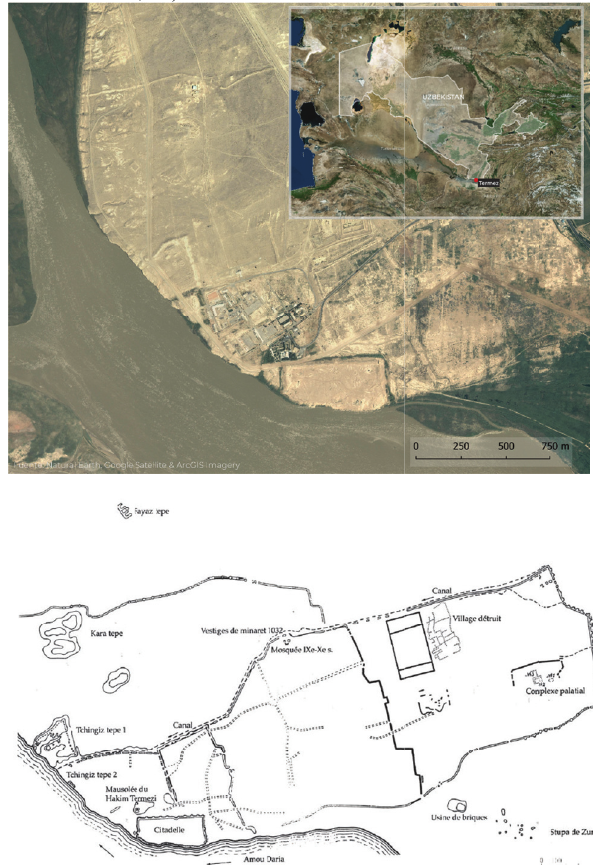
Figure 1. Loc close to the b (Natural Ear (above).